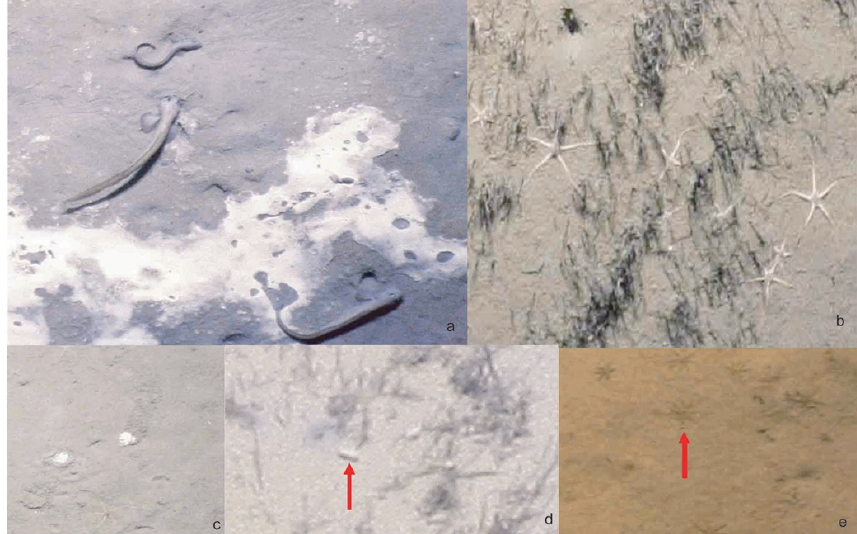
Fig. 3. Most abundant species on the OFOS images. (a) Lycodes squamiventer (Pisces), (b) Ophiocten gracilis (Ophiuroidea), (c) Bivalvia gen. sp (whitish form), (d) Lysianassidae (Amphipoda), (e) Nymphon macronix